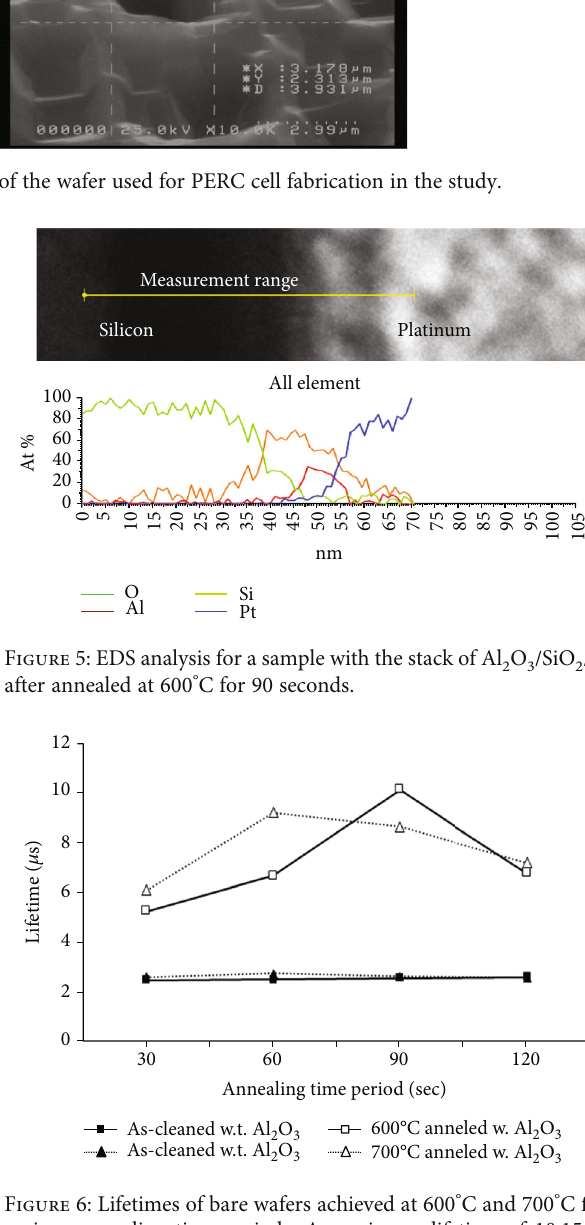
Figure 4: XPS measurement of elements near the surface of an annealed sample with ozone-treated Al